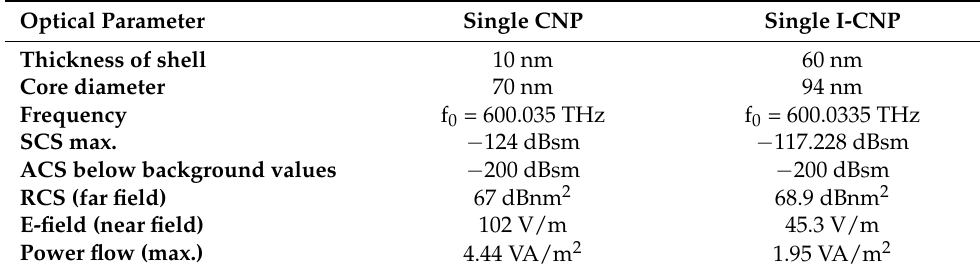
Table 1. Optical properties of the single basic active CNP. Optical